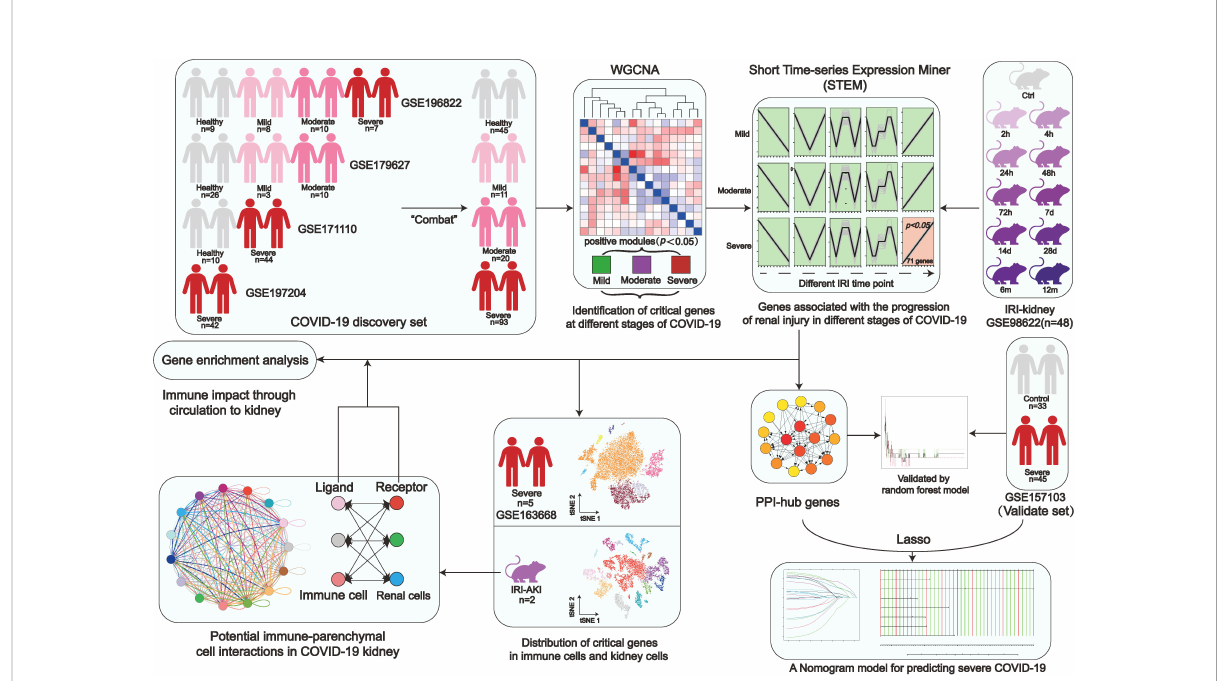
FIGURE 1 Study work fl ow. Coronavirus disease 2019, (COVID-19); Weighted gene co-expression network analysis, (WGCNA); Ischemia-reperfusion injury, (IRI); Kyoto encyclopedia of genes and genomes, (KEGG); Protein-Protein interaction,